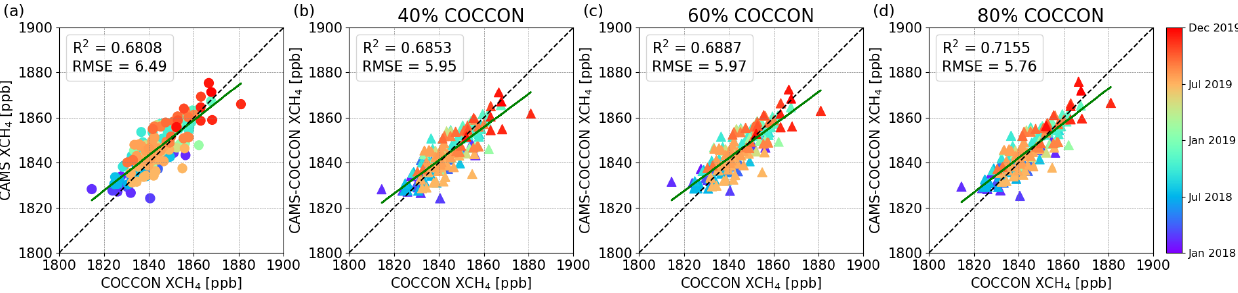
Figure A10. Correlation plots of (a) CAMS and (b–d) CAMS-COCCON with respect to COCCON XCH 4 at Karlsruhe. The CAMS- COCCON datasets are based on 40%, 60% and 80% of COCCON measurement days.